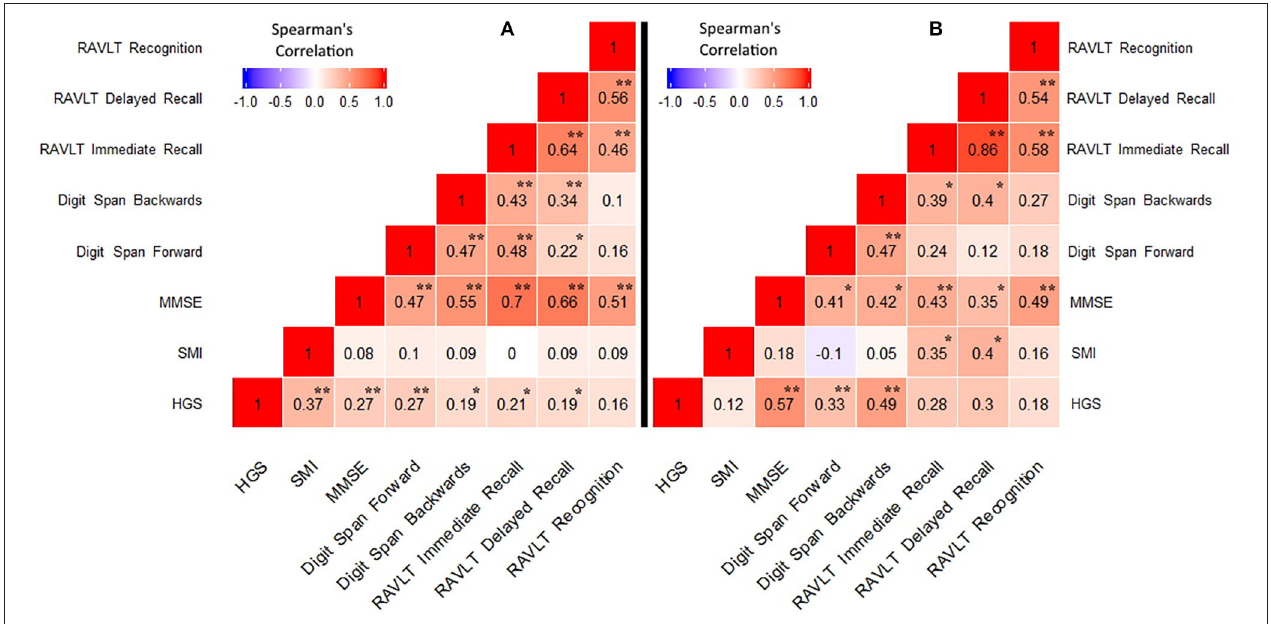
FIGURE 1 | Correlations between handgrip strength, skeletal muscle index, and neuropsychological data. (A) MCI/AD dementia group; (B) Control group. HGS, Handgrip strength; SMI, skeletal muscle index; MMSE, Mini Mental State Examination; RAVLT, Rey Auditory Verbal Learning Test. * p < 0.05, ** p < 0.005.